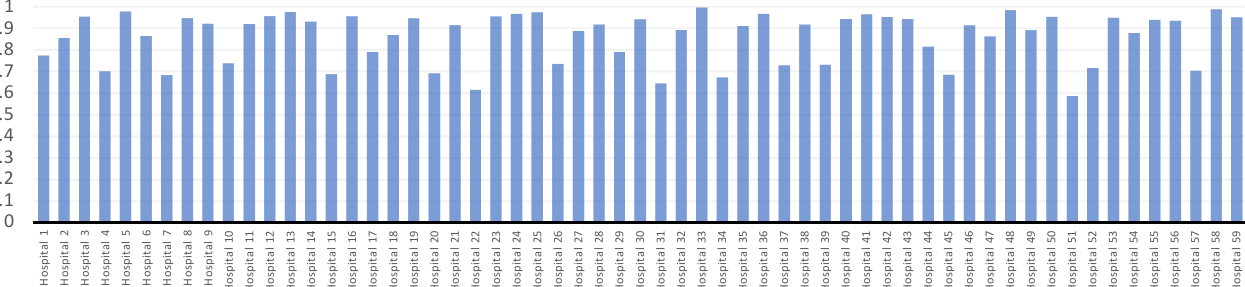
scores of 0.584, 6.13, and 0.643 respectively.